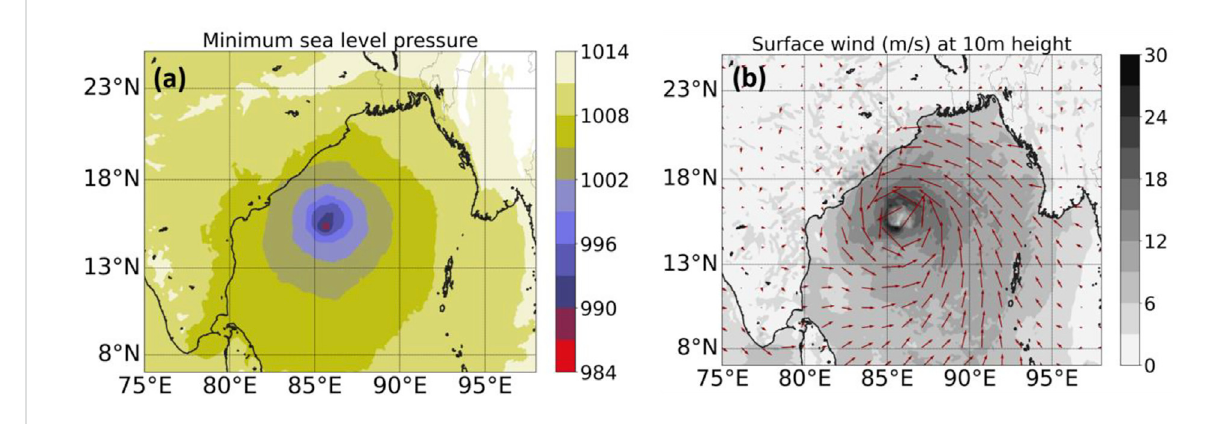
FIGURE 7 Spatial distribution of (A) MSLP and (B) 10-m surface wind during the life of cyclone Titli (2018) over the ARB using the high-resolution WRF model.